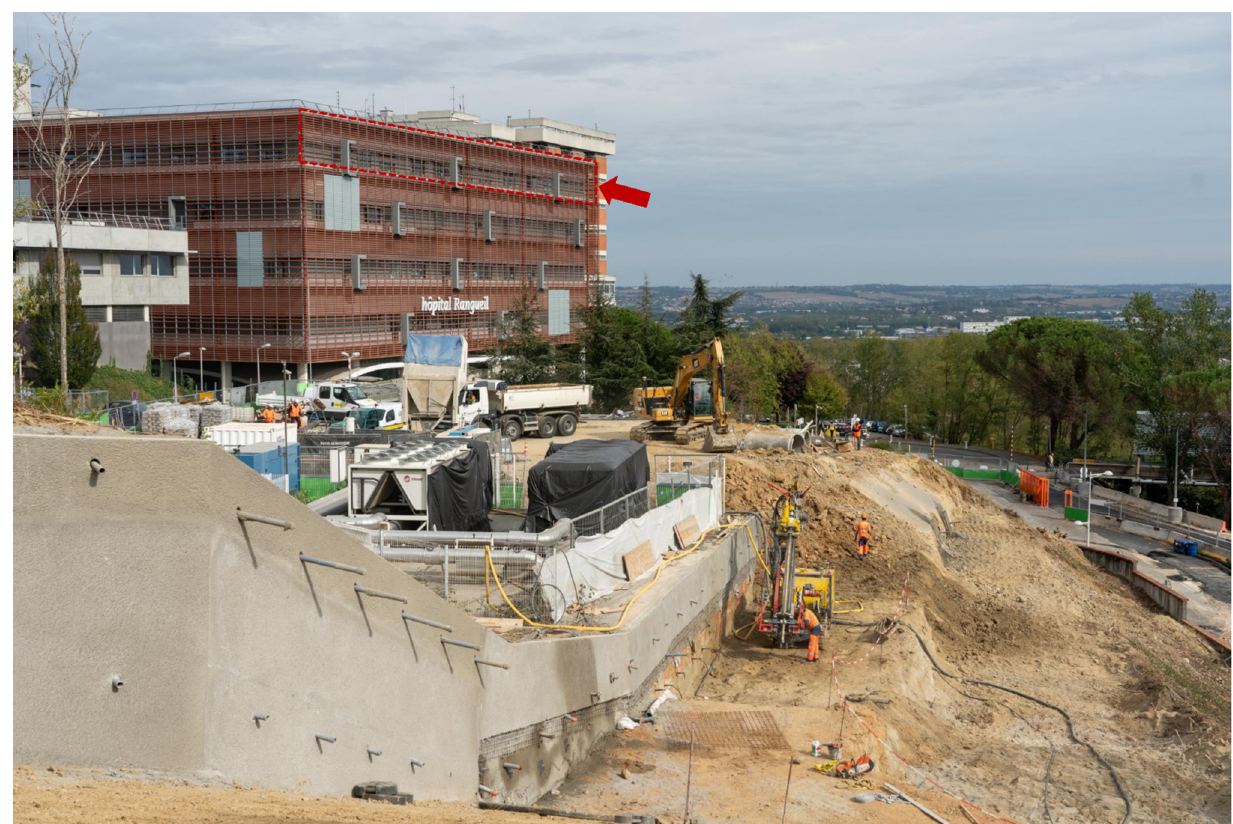
Figure 3. Picture showing the construction work and the localisation of the Rangueil ICU. The red box indicates the ICU floor where the COVID-19 patients were hospitalised. Photo courtesy of Tisséo Ingénierie—Airimage (© Tisséo Ingénierie—Airimage).